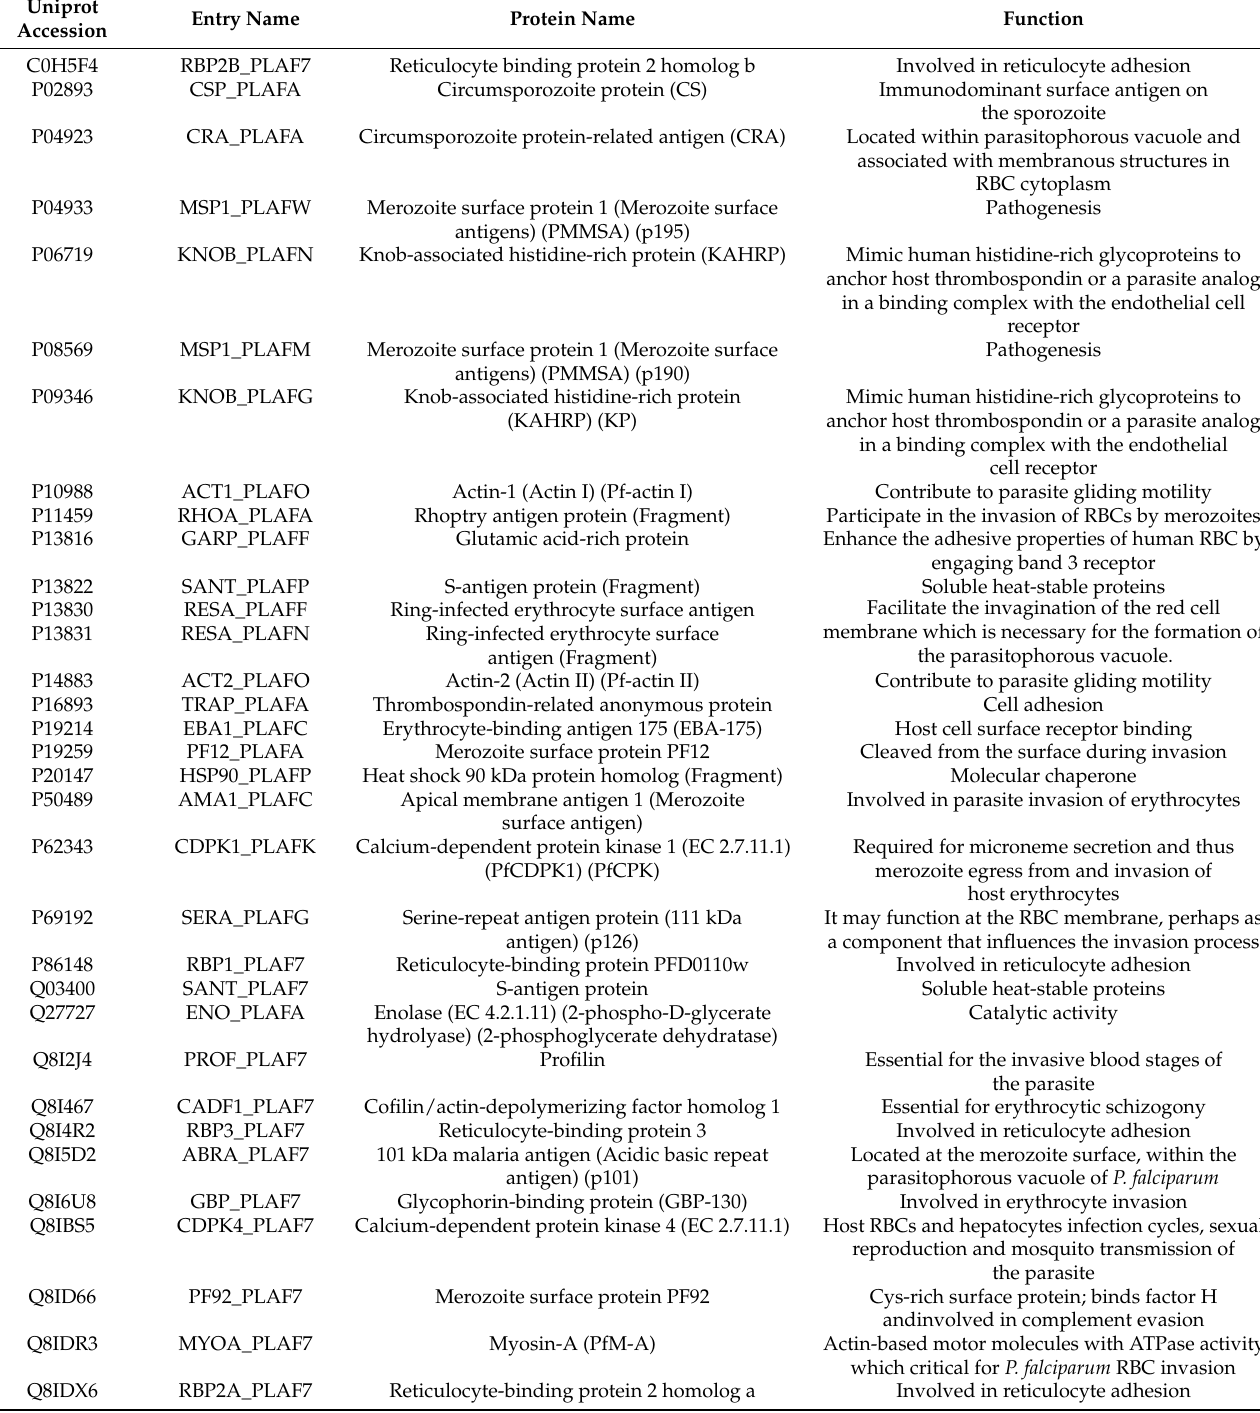
Table 2. List of invasion-associated P. falciparum proteins detected in Pf -